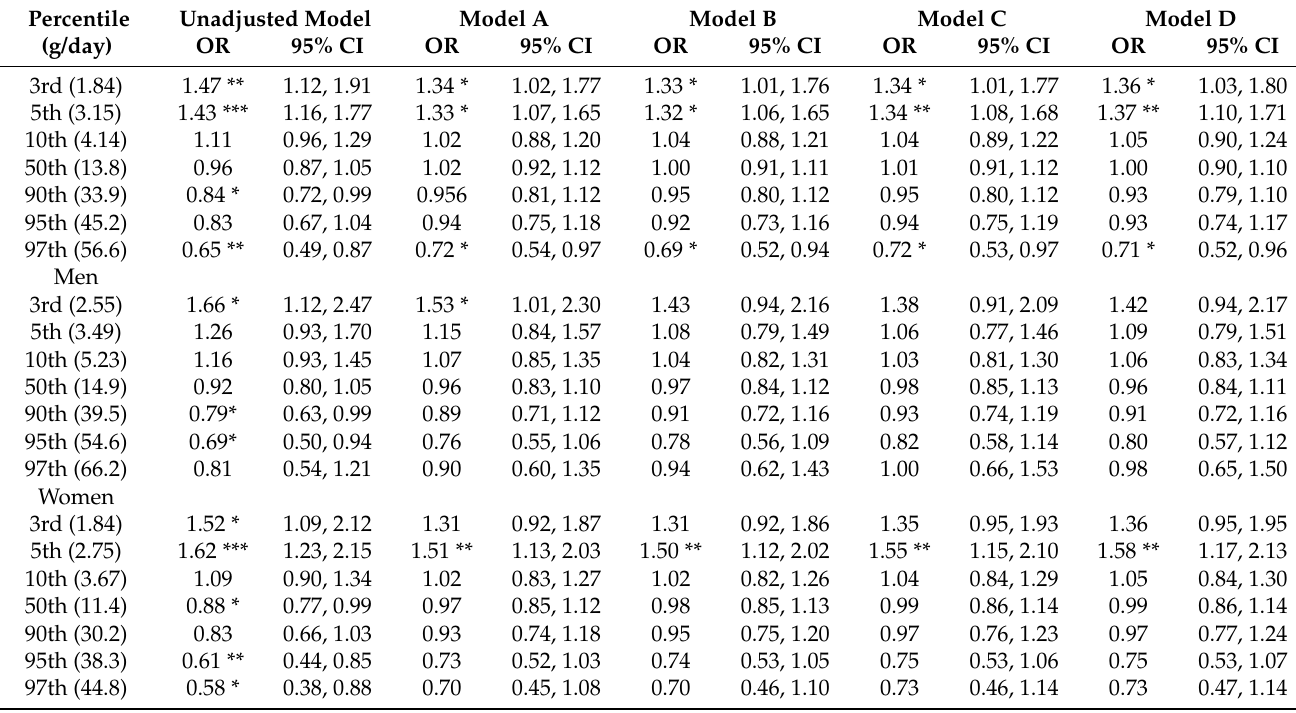
Table 2. Odds of hypertension (defined as either systolic or diastolic blood pressure over 140/90)